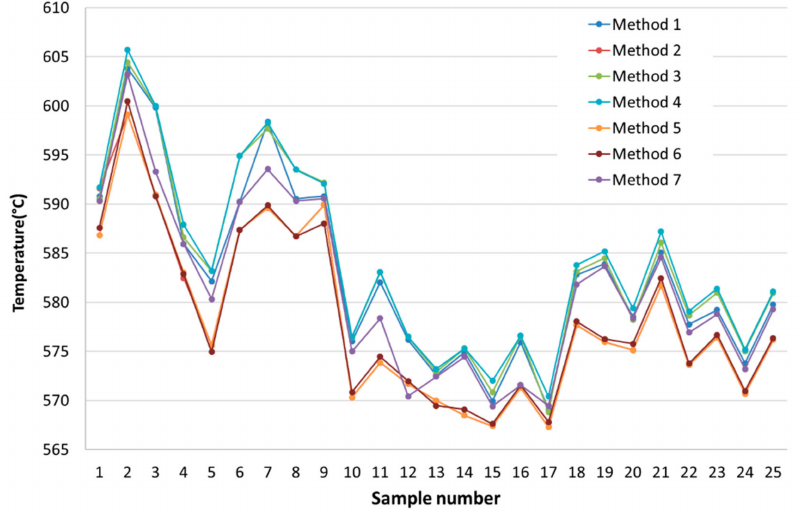
Figure 9. The comparison of the DCP temperatures for every sample with the studied